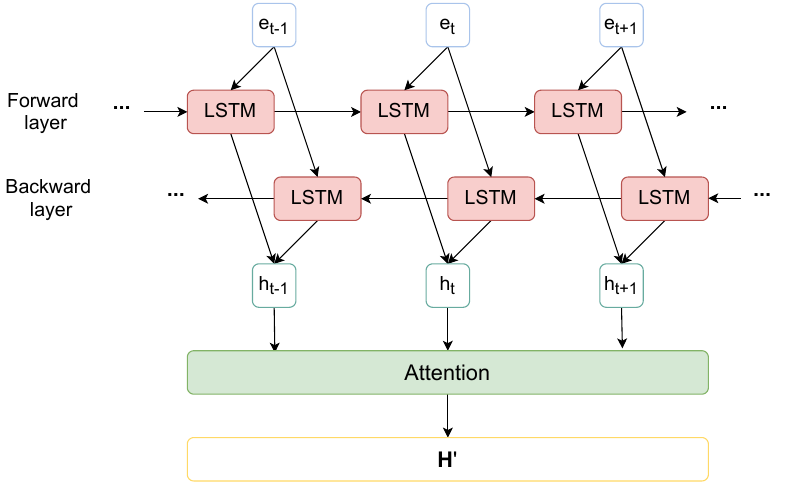
Figure 5. Module II: BiLSTM with attention.